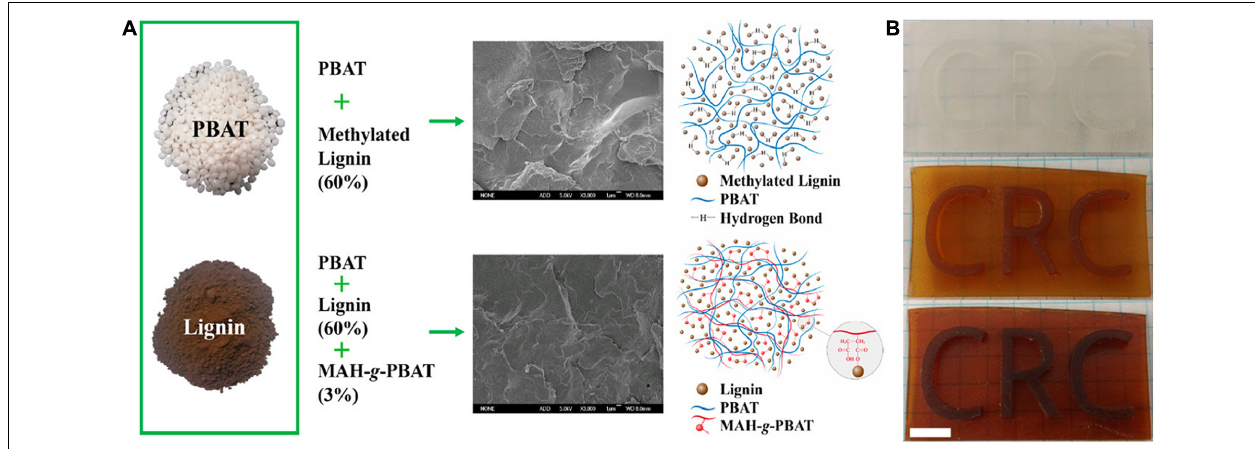
FIGURE 4 | (A) Preparation of a composite by blending PBAT and Eucalypt hydrothermal lignin via two strategies (Xiong et al., 2020); (B) Digital photos of 0%, 5%, and 10% lignin (from top to bottom) exhibiting the effect on print quality (Sutton et al., 2018).